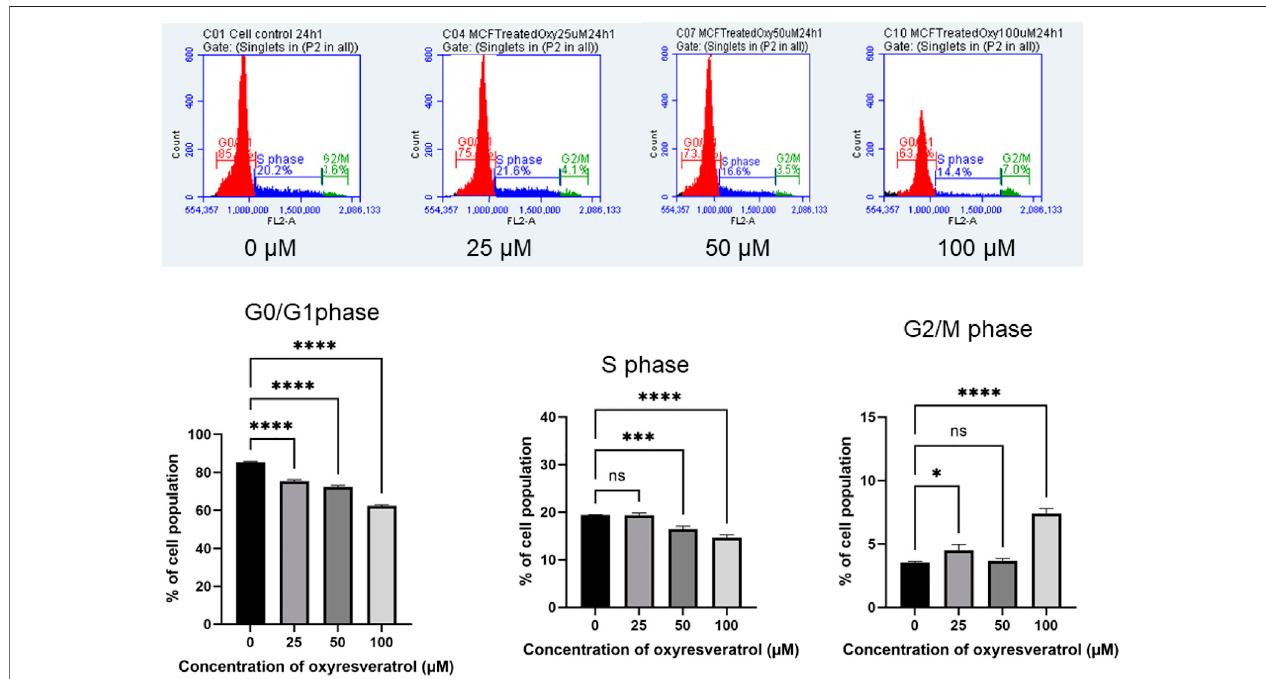
FIGURE 10 | Effect of OXY on cell cycle distribution in MCF-7 cells determined using fl ow cytometry. The histograms showing the numbers of cells in different phases after MCF-7 cells were treated with 25 – 100 μ M OXY for 3 – 24 h and then subjected to fl ow cytometric analysis. Data are the mean ± SD of three experiments. Statistical analysis was carried out using One-way ANOVA analysis of variance followed by Dunnett ’ s test. The signi fi cant difference was compared relatively to control (* p (cid:2) 0.0134, *** p (cid:2) 0.002 and **** p < 0.0001).